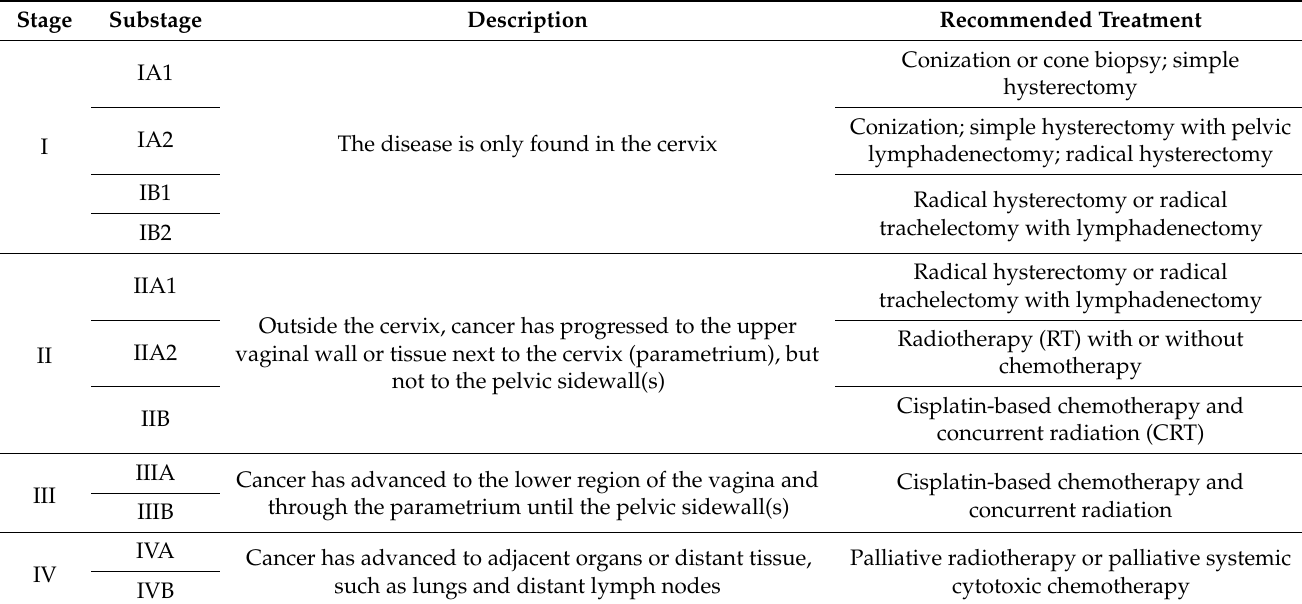
Table 1. CC stages according to the FIGO system and the recommended